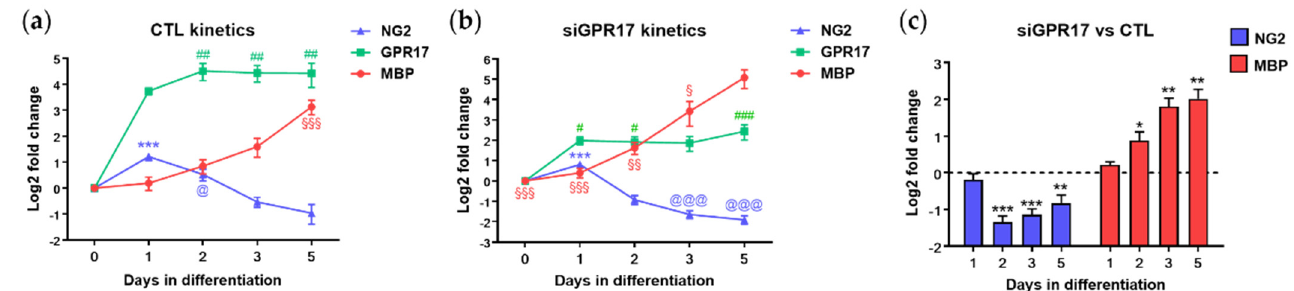
Figure 4. Effect of GPR17 silencing on OPC maturation. The expression levels of GPR17 (green), NG2 (blue) and MBP (red) were evaluated by real-time PCR during differentiation in control conditions ( a ), cells transfected with scramble RNA and after GPR17 silencing ( b ), and normalized versus expression at T0 (set to 0). n = 6 per each time point. One-way ANOVA with Tukey’s multiple comparisons test. ( a ): *** p < 0.001 vs. DID 0-2-3-5, @ p < 0.05 vs. DID 3-5; ## p < 0.01 vs. day 0; §§§ p